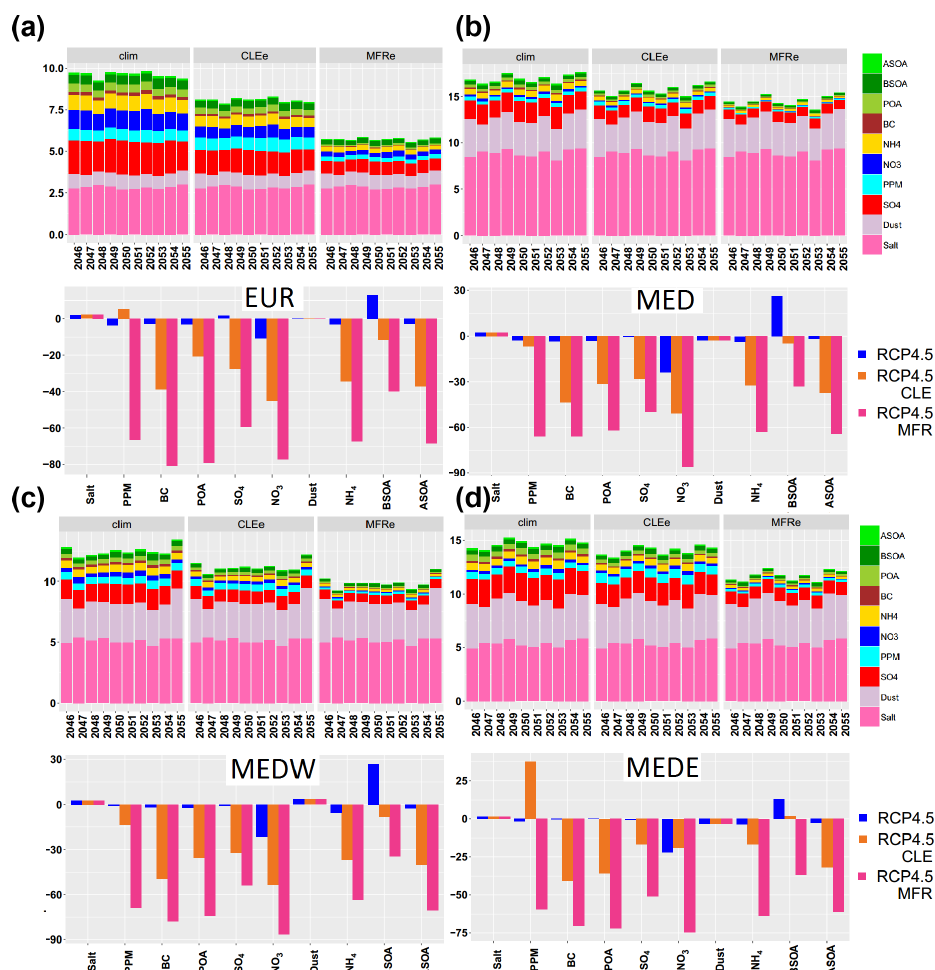
Figure 13. Emission scenario comparisons. Each panel shows one subdomain, the upper subpanels show the PM 10 components for each scenario, the lower subpanels shows the percentage difference for each scenario ((future − historic) / historic ·